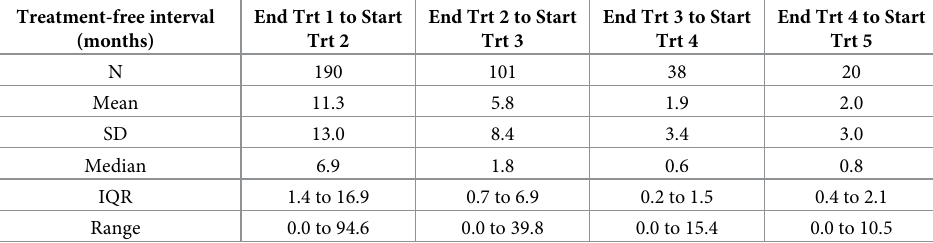
Table 5. Treatment-free interval in the total cohort following first-line and subsequent lines of therapy. Treatment-free interval (months)